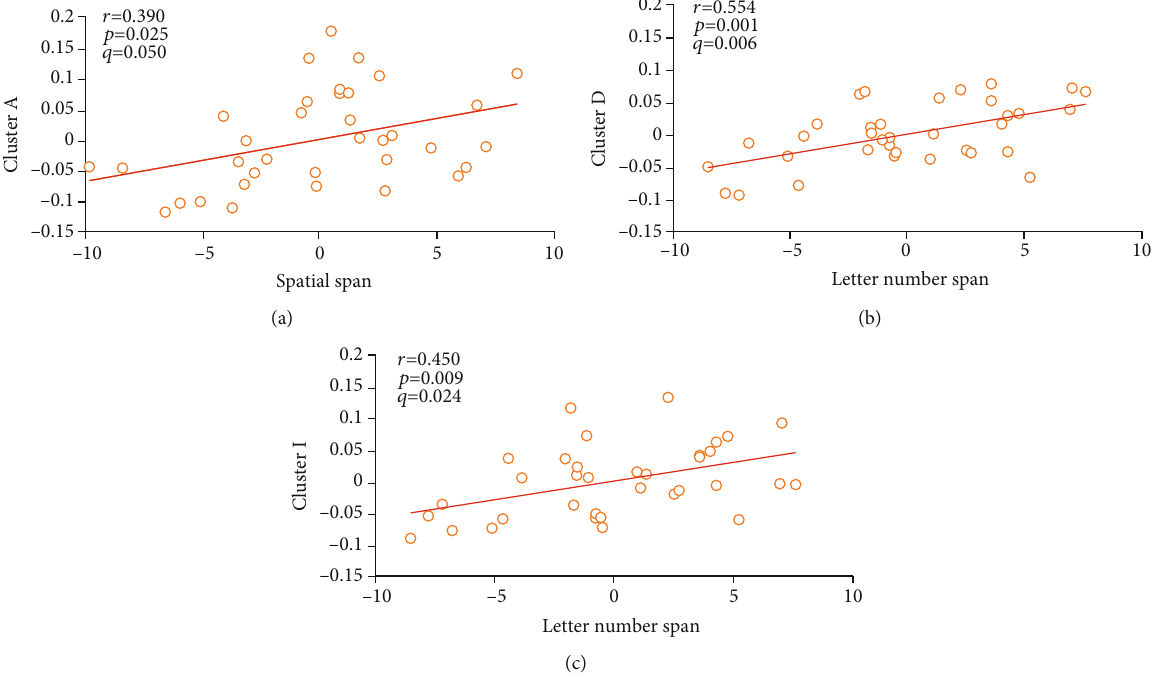
Figure 3: Correlations between MCCB scores and GMVs in BD. Signi fi cant at q < 0 : 05 , FDR